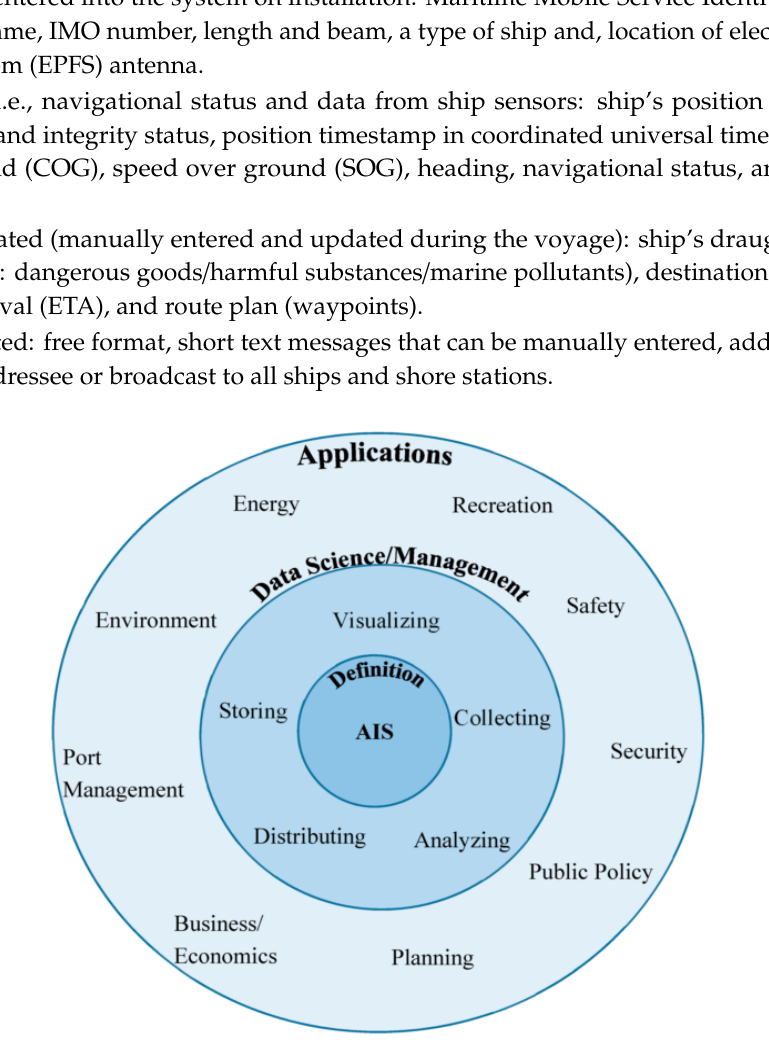
Figure 2. AIS systems overview (adapted from IMO A29/Res. 1106, P.4).